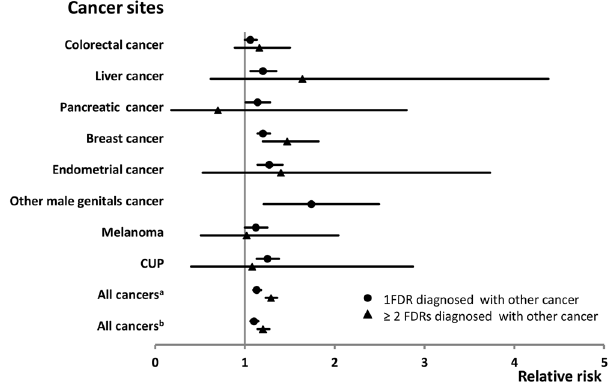
Figure 2. Ovarian cancer risk when only one or at least two first-degree relatives were diagnosed with other cancers. Only significant cancer sites are shown. CUP: cancer of unknown primary; a all cancers include ovarian cancers and all other cancers; b all cancers include all other cancers except ovarian cancer. FDR, first-degree